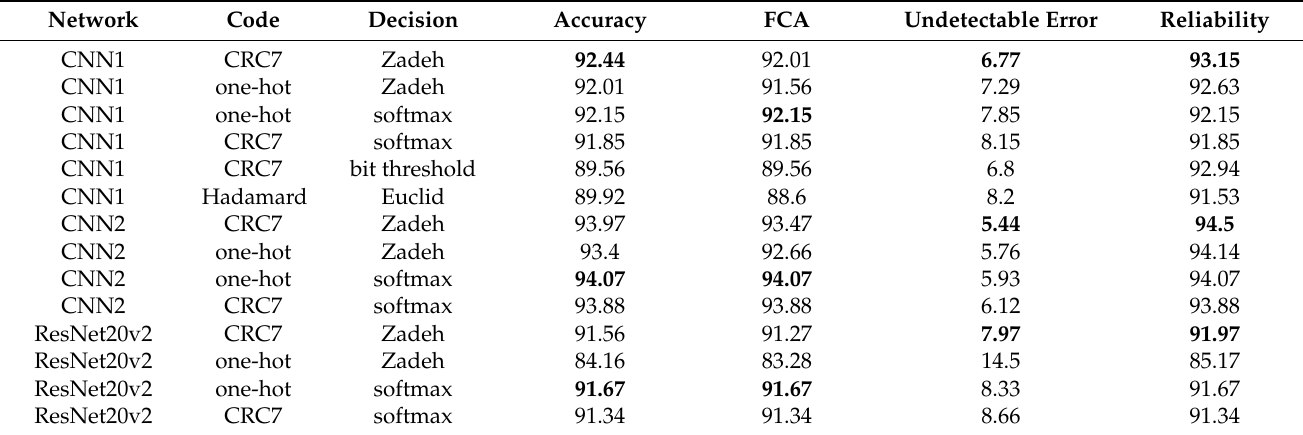
Table 4. Performance of the various output coding and decision